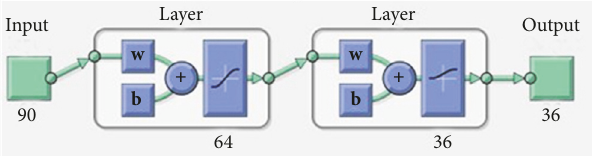
Figure 14: Structure of the letters and numbers mixed classifier based on